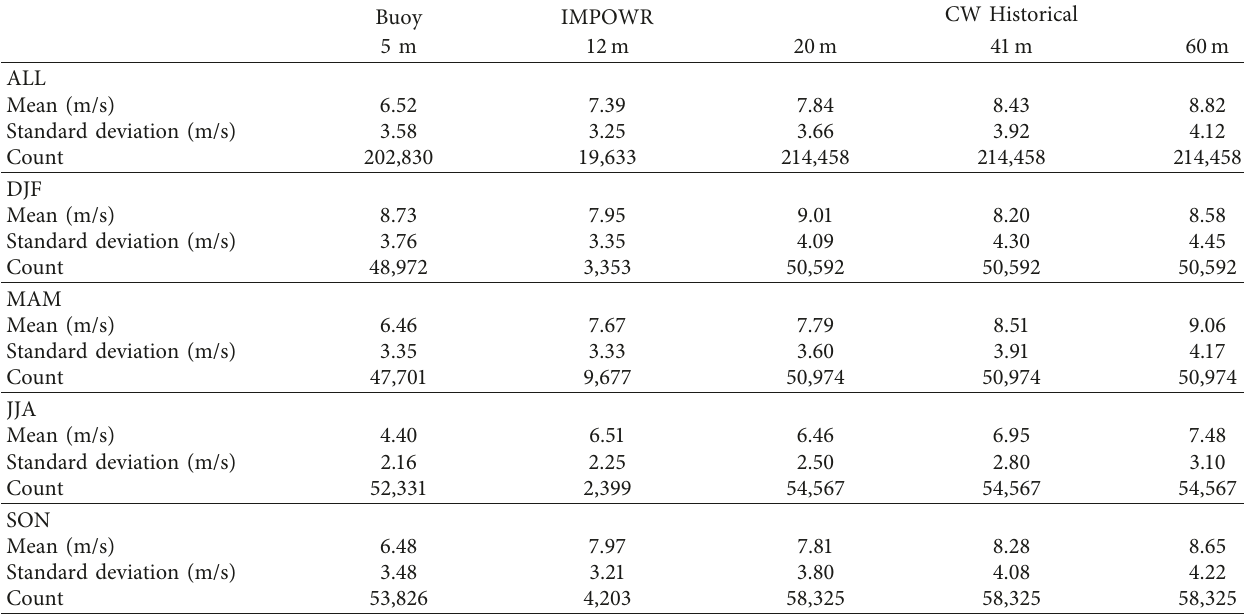
Table 2: Mean and standard deviation of wind speed (by season and overall) measured from buoy 44020 during 2003–2007 at 5 m, the IMPOWR campaign during 2013–2014 at 12m, and the CW tower during 2003–2007 at three different heights. All heights are in meters above mean sea